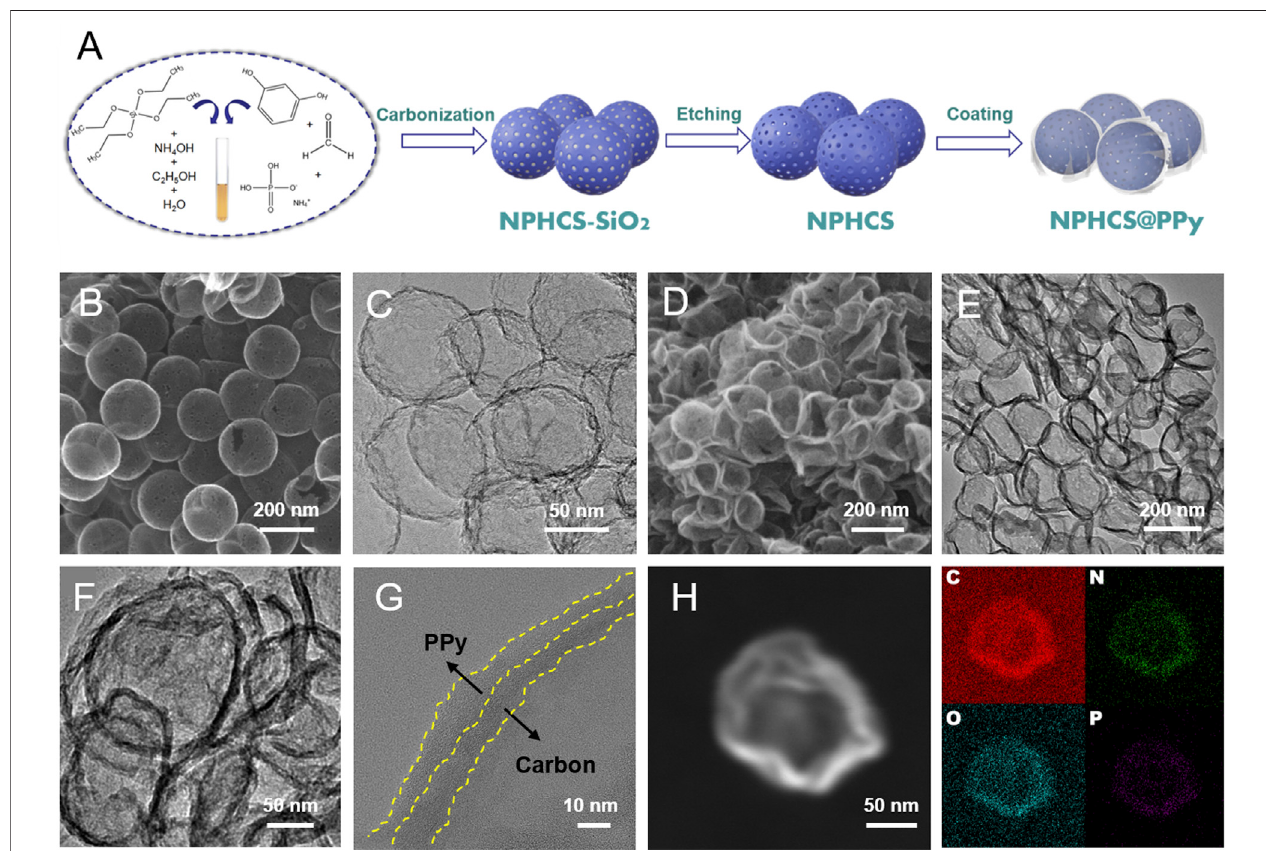
FIGURE 1 | (A) Synthesis schematic of NPHCS@PPy (B) SEM and (C) TEM images of NPHCS (D) SEM (E, F) TEM (G) HR-TEM and (H) EDS elemental mapping images of NPHCS@PPy.